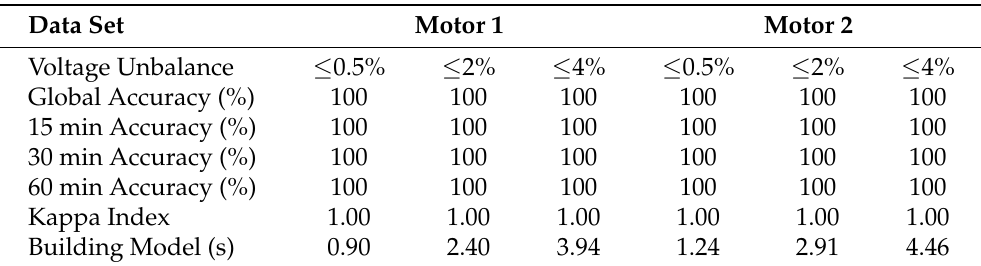
Table 7. Experimental results using the 450 SMI attributes among i a , i b and i c —Severity analysis of bearing